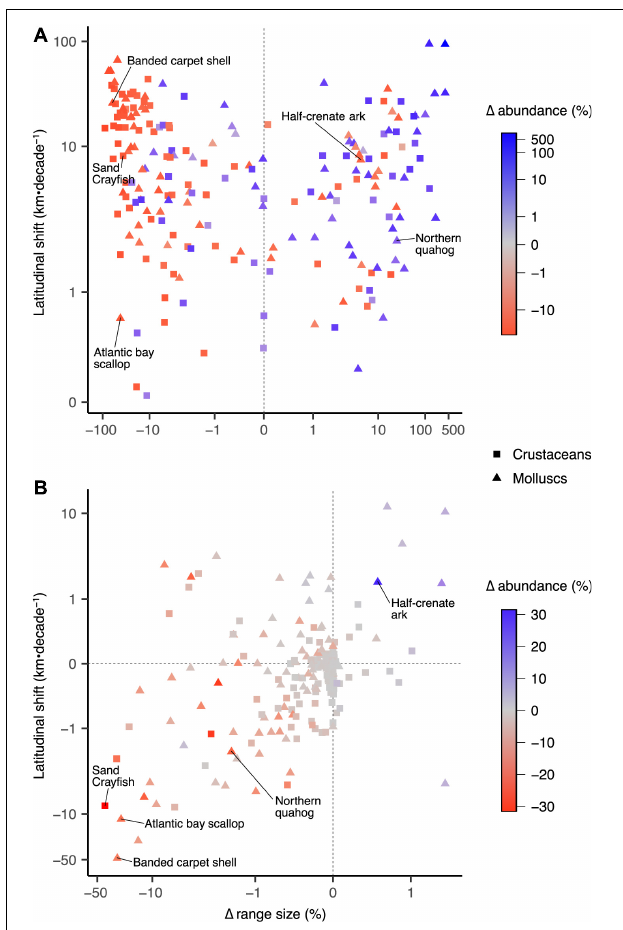
FIGURE 5 | Biogeographical changes in range size, abundance, and distributional shift of latitudinal centroids for 210 invertebrate fisheries species in the high CO 2 scenario. (A) Responses to global change drivers excluding ocean acidification, and (B) responses to ocean acidification separated from other stressors. Values shown are multi-model means for 2091–2100 period relative to 1951–1960. Correlations between variables are shown in Supplementary Table 1 . Note log scales.